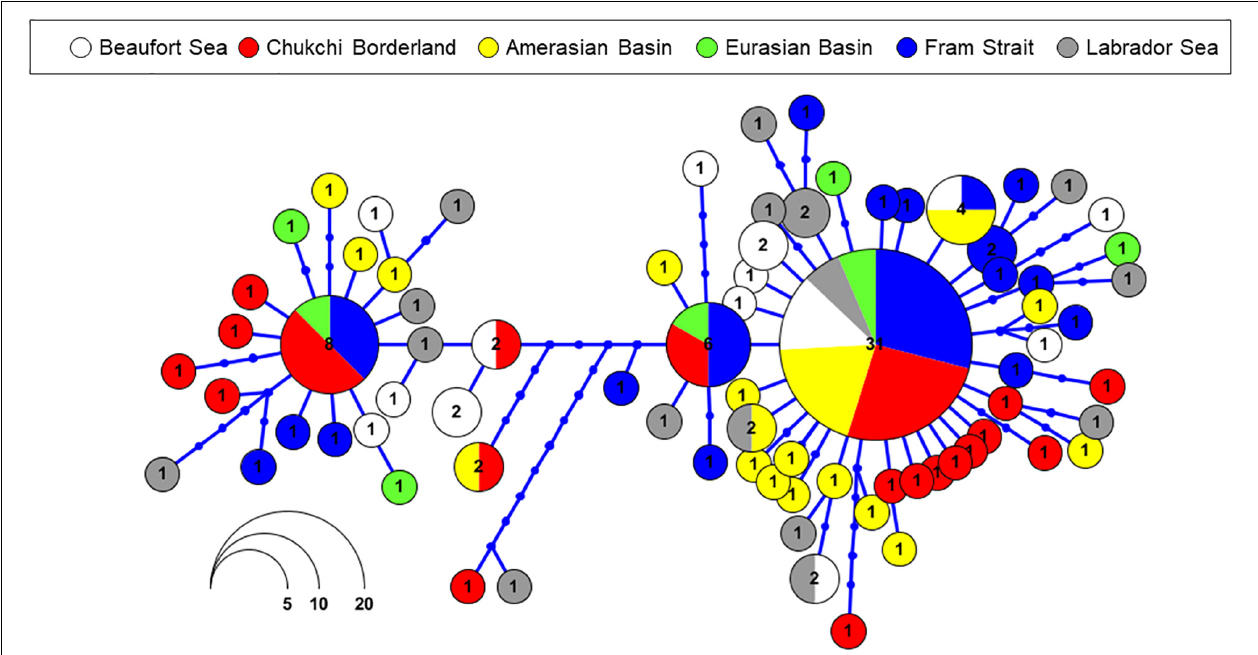
FIGURE 3 | Haplotype network for E. hamata based on mtCOI sequences. Each circle represents a unique haplotype. Circle size and color correspond to the number of haplotypes and geographic location, respectively. Cross-bars represent number of mutations between haplotypes. Color key: white: Beaufort Sea; red: Chukchi Borderland; yellow: Amerasian Basin; green: Eurasian Basin; blue: Fram Strait; gray: Labrador Sea.